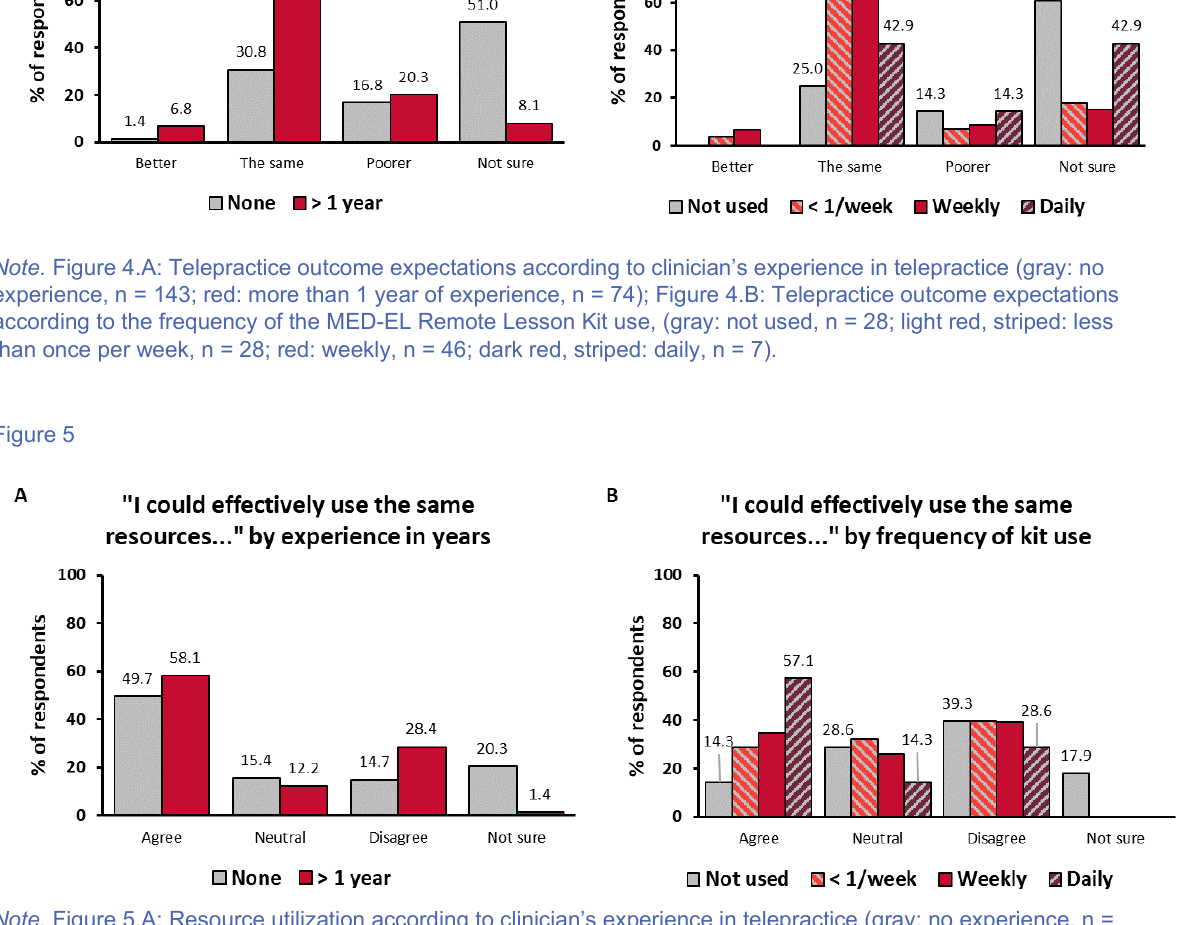
Note. Figure 5.A: Resource utilization according to clinician’s experience in telepractice (gray: no experience, n = 143; red: more than 1 year of experience, n = 74); Figure 5.B: Resource utilization expectations according to the frequency of the MED-EL Remote Lesson Kit use, (gray: not used, n = 28; light red, striped: less than once per week, n = 28; red: weekly, n = 46; dark red, striped: daily, n =